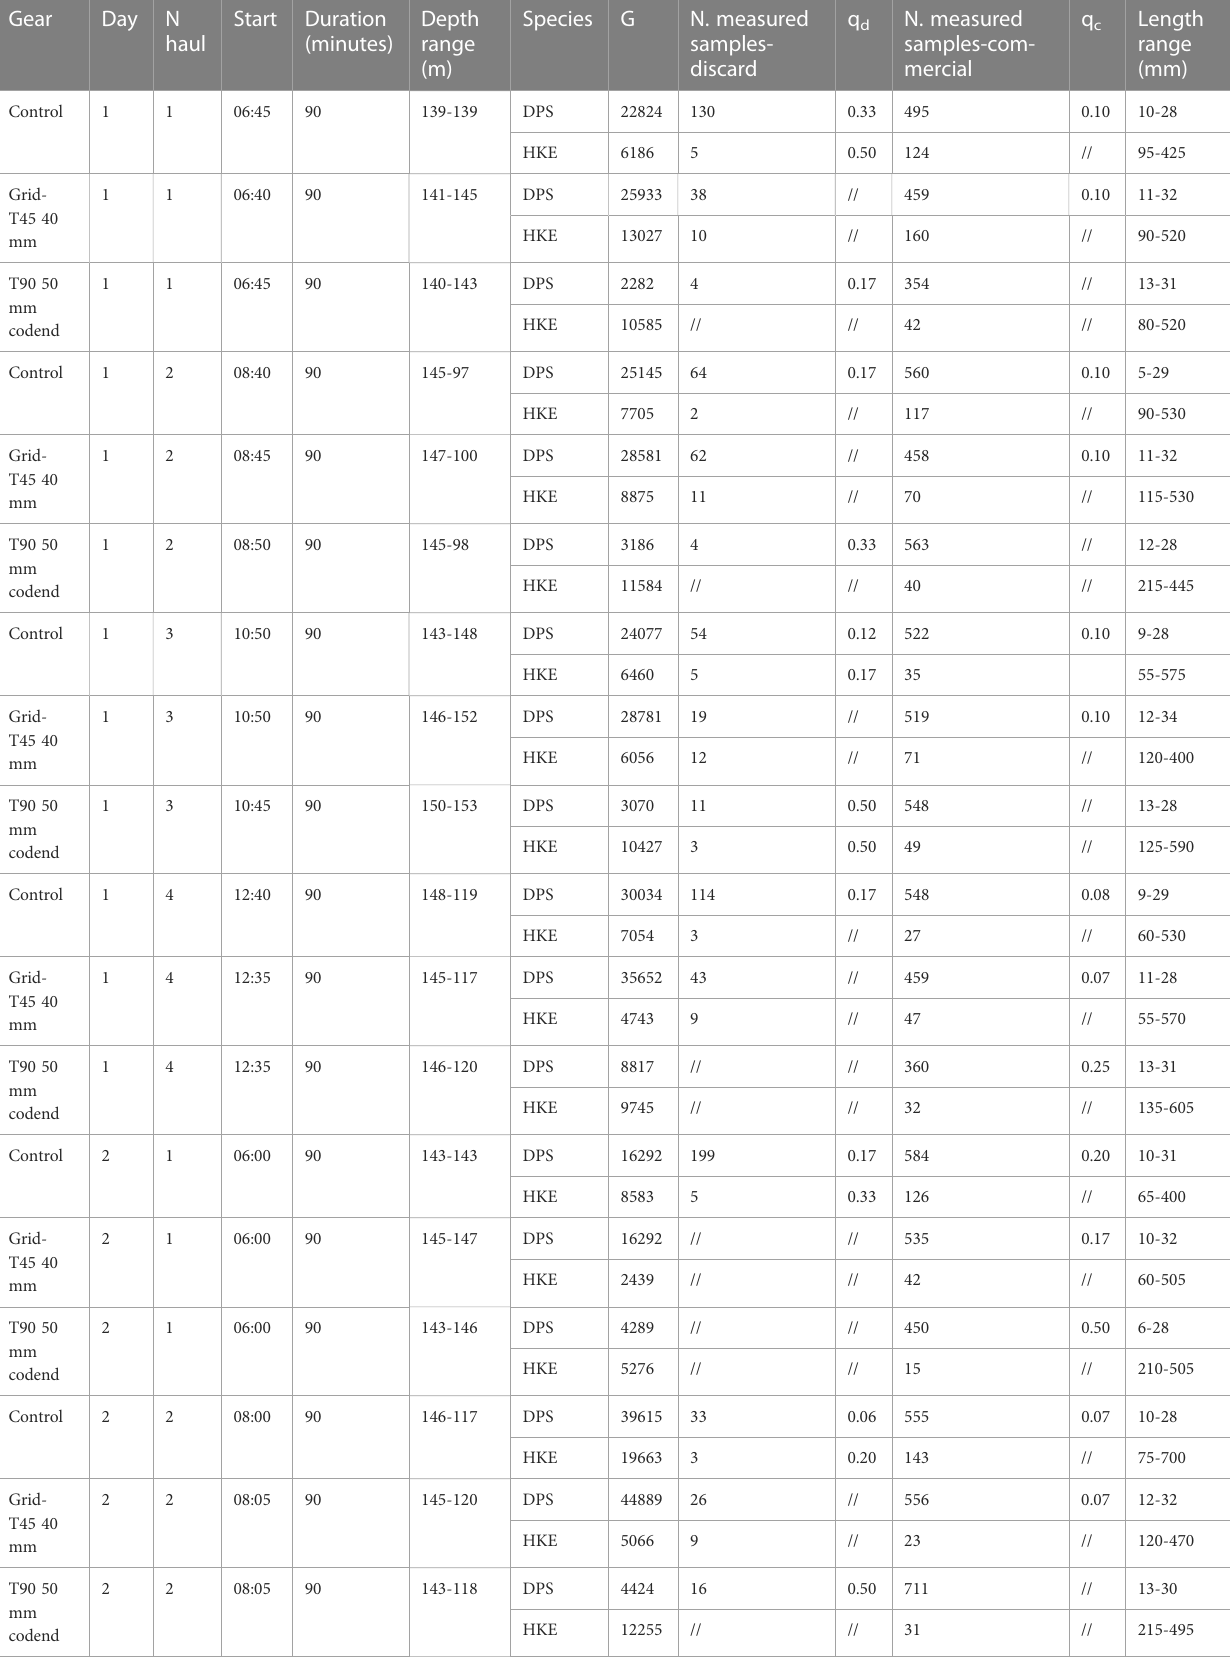
TABLE 1 Description of the fi shing operations by haul carried out during the